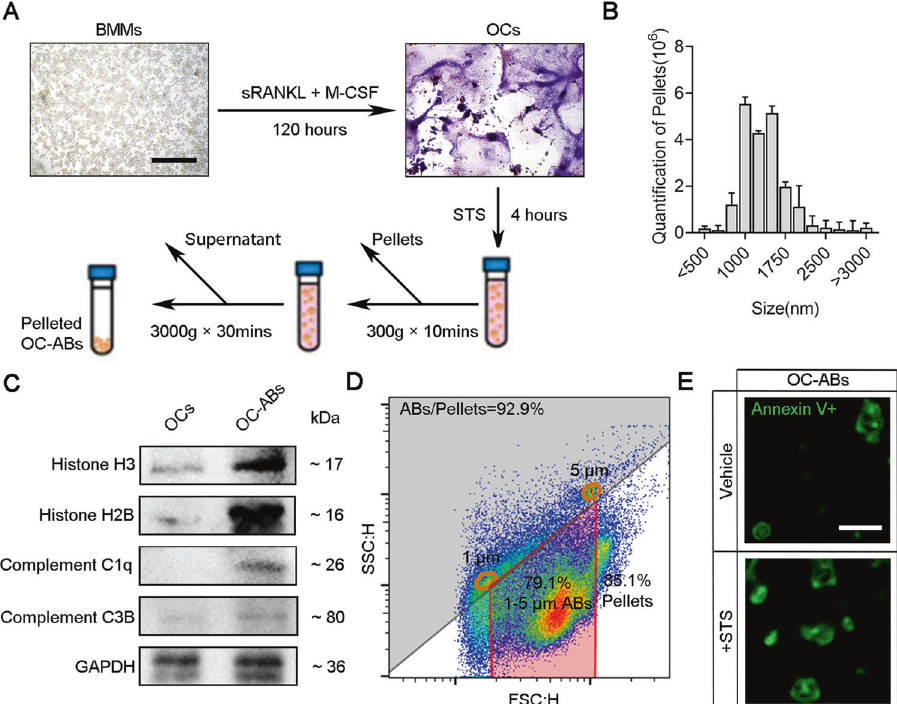
Fig. 2 Extraction and identi fi cation of osteoclast-derived apoptotic bodies. A Schematic diagram of osteoclast apoptosis induction and apoptotic body extraction. B Nanoparticle tracking analysis of OC-ABs, n = 3. C Western blot result of H3, C1QC, H2B, C3B in OCs lysate and pelleted OC-ABs. D cytometry analyze result of OC-ABs purity. 1 μ m and 5 μ m diameter beads were used to gate 1 – 5 μ m sized microvesicles. E Representative confocal images of OC-ABs (stained with FITC-Annexin V). Scale bar = 2 μ m. The data in each panel represent the means ±